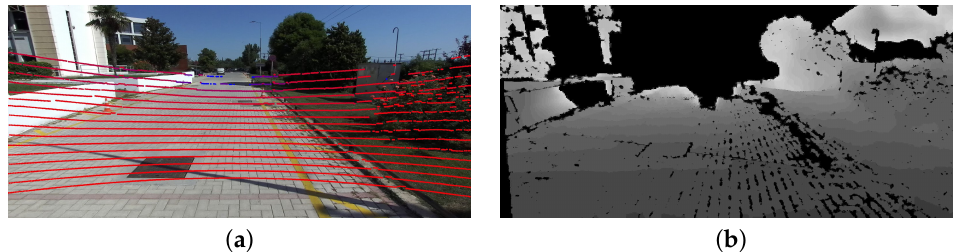
Figure 3. Sample data from an autonomous vehicle equipped with an RGB stereo camera and a LiDAR sensor. ( a ) LiDAR points projected on the RGB image plane, providing sparse but accurate measurements. ( b ) Depth image coming from a stereo camera, providing dense depth